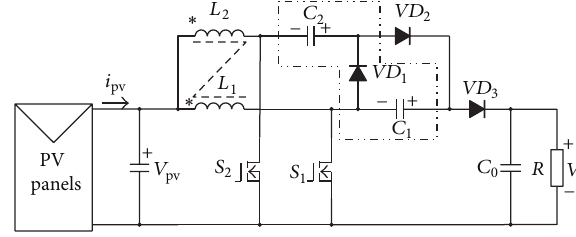
Figure 2: The new converter.